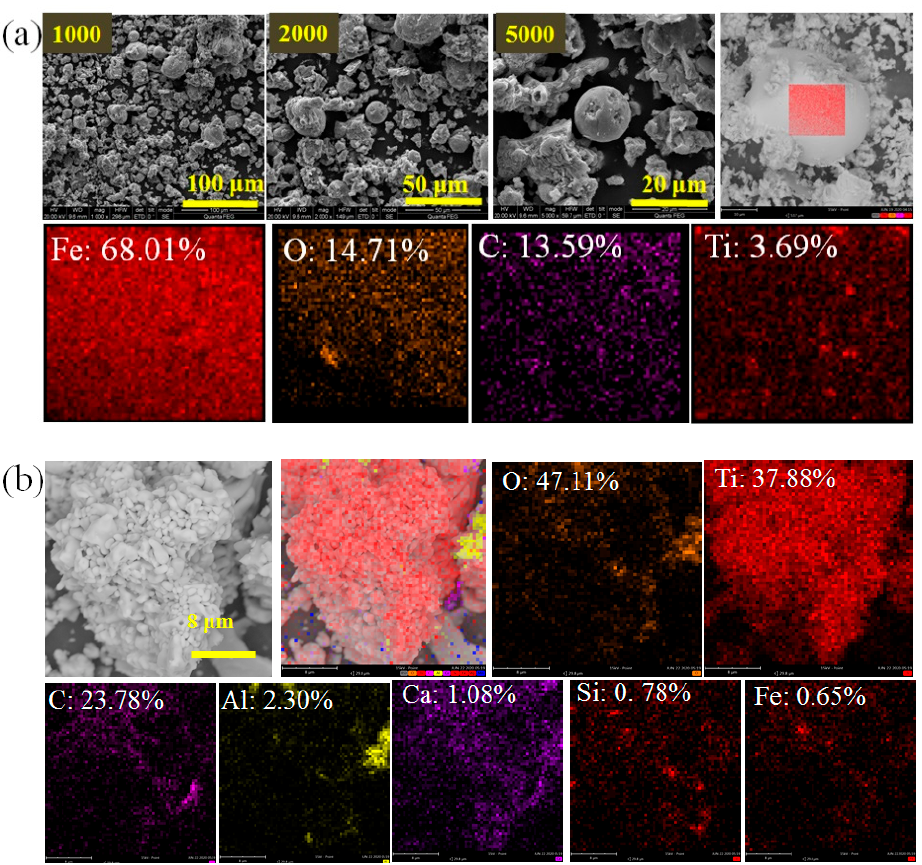
Figure 8. ( a ) SEM-EDS of the spherical shape reduction product; ( b ) SEM-EDS of the aggregated particles (EDS: atomic concentration). Scale bar ( b ): 8 µ